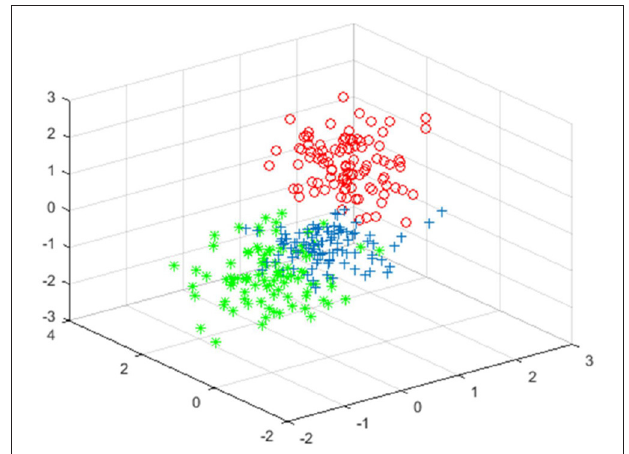
FIGURE 7 | The clustering effect map of the data after noise